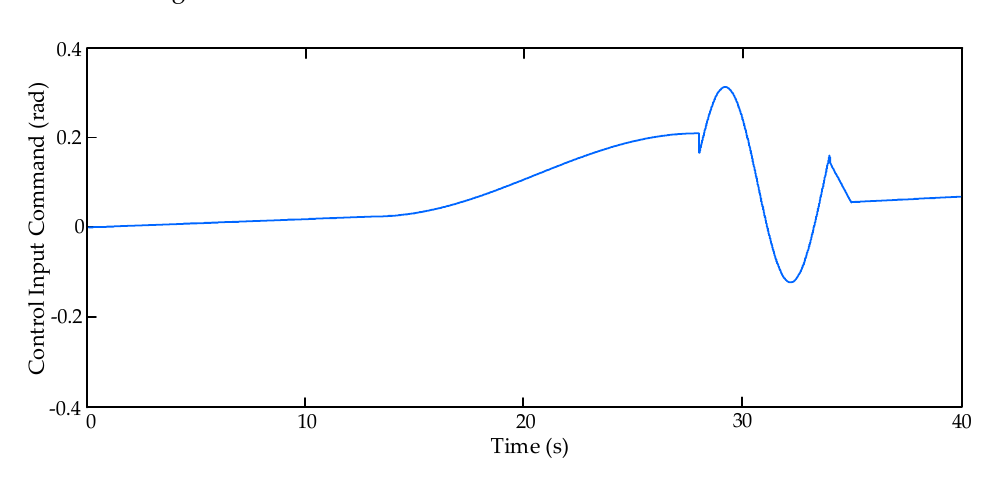
Figure 10. Tracking errors with real flight control command under random perturbance.